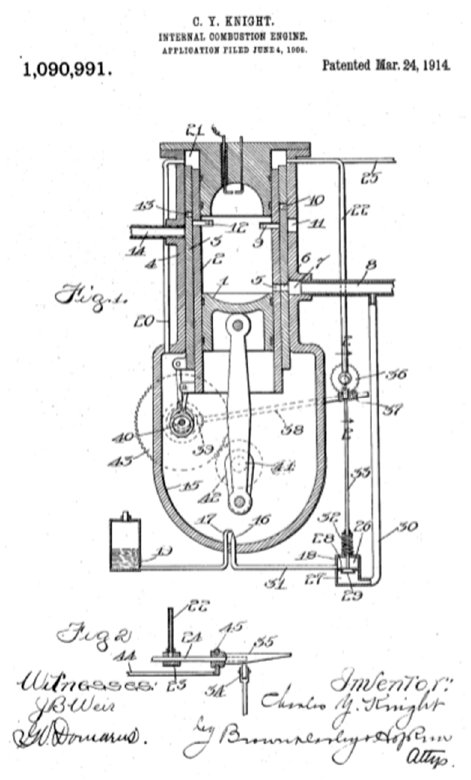
Figure 2. C.Y. Knight patent for internal combustion engine US patent 1090991 filed 4 June 1906.